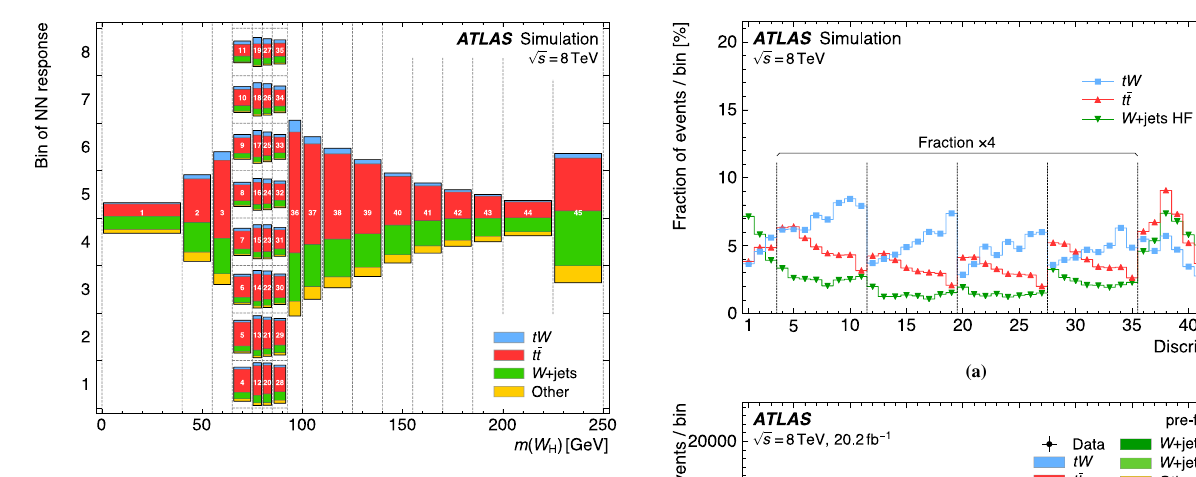
Fig. 5 Predicted distribution of the two-dimensional discriminant in the signal (3j1b) region. The proportions of the coloured areas reflect the expected composition in terms of tW , t ¯ t , W + jets and other pro- cesses. The numbers correspond to the bin order when projecting the discriminant onto one axis as in Fig. 6. The last bin on the horizontal axis includes the overflow events